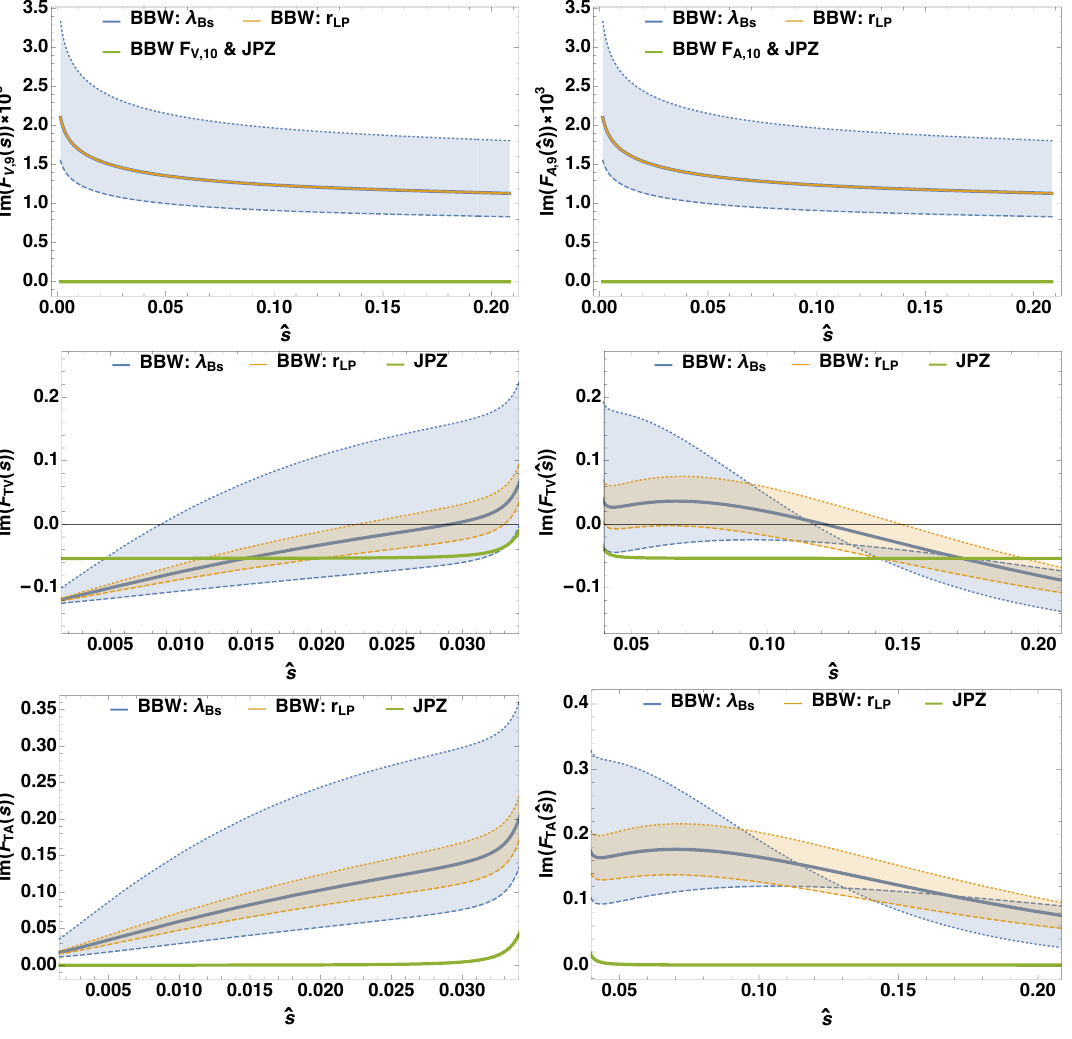
Figure 7 . Same as figure 6, but for the imaginary parts of the BBW vs. JPZ